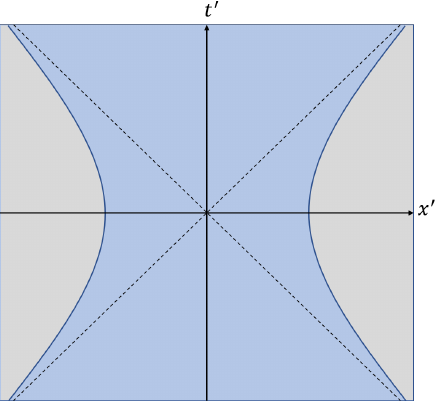
Figure 10. The Lorentz geometry viewed along z -axis. The boundary of the EOW brane (blue region) becomes hyperbolic curves. The horizon on the brane is represented by dashed